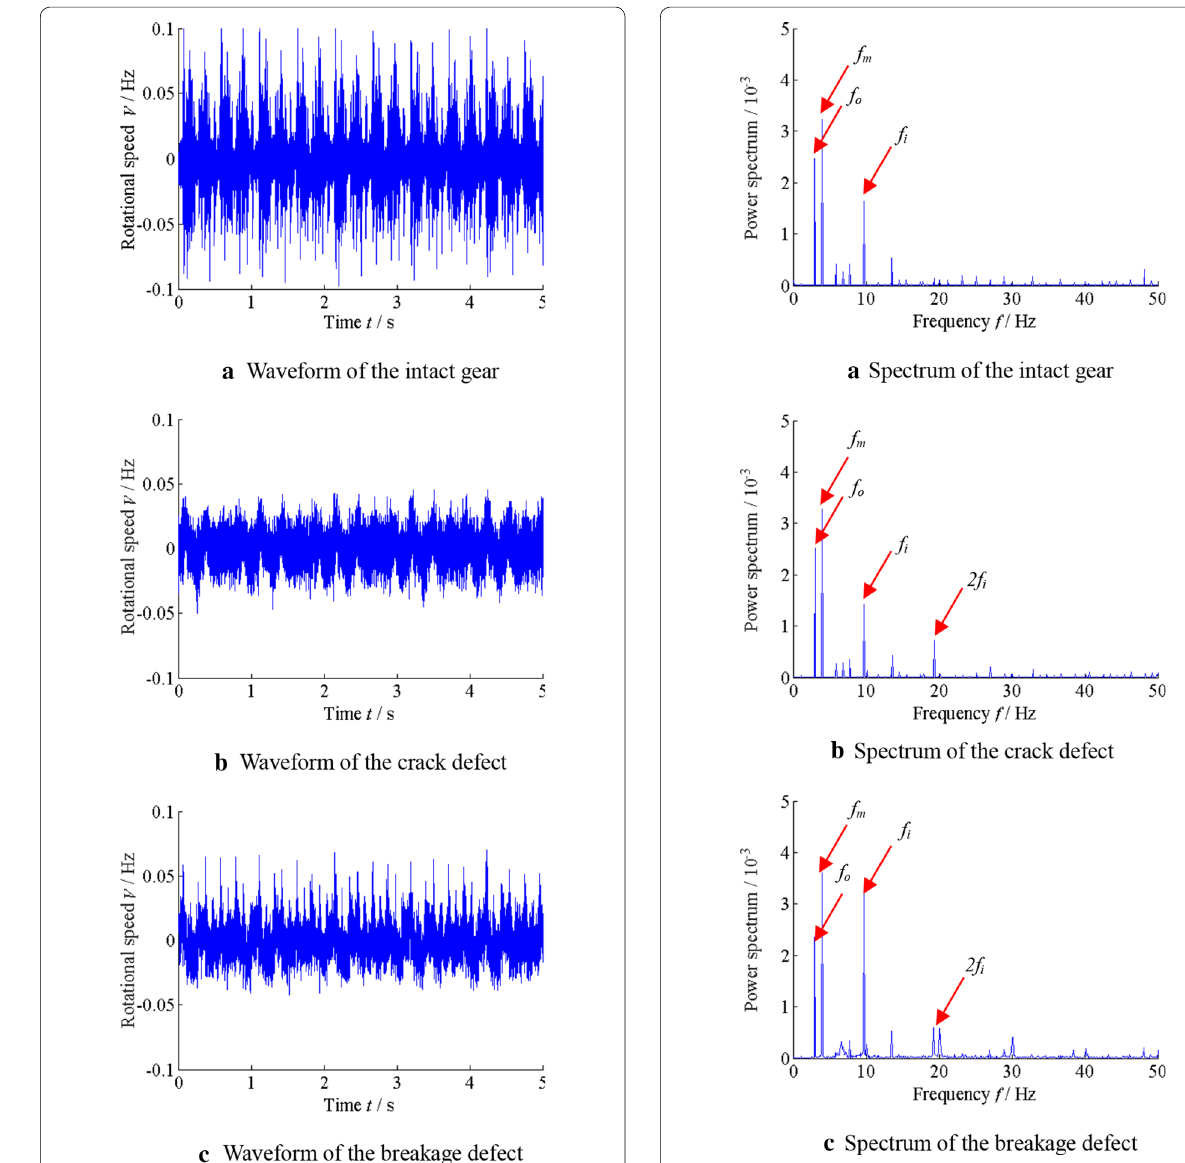
Figure 6 Differential signals at a speed of 10 Hz Figure 7 Spectra of differential signals at a speed of 10